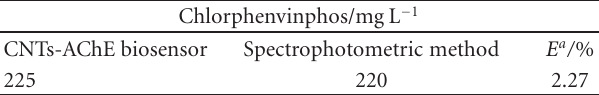
Table 3: Determination of chlorphenvinphos in insecticide sample using CNTs-AChE biosensor and spectrophotometric